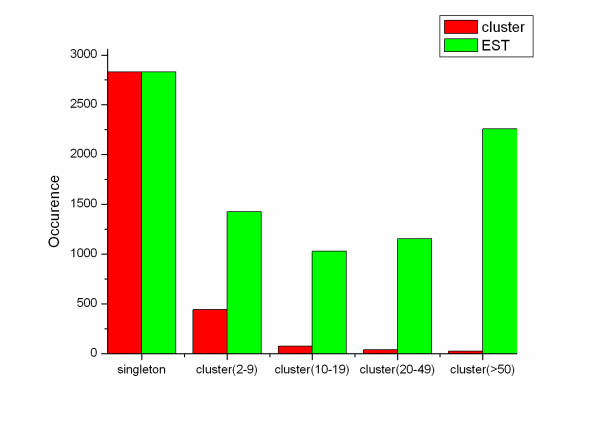
Prevalence distribution of the cluster size. The initial 8696 ESTs were grouped into 3416 clusters, consisting of 25 clusters (2257 of 8696 ESTs) that compromised of more than 50 ESTs each cluster, 39 clusters contained 20~49 ESTs (1153 of 8696 ESTs), 75 clusters contained 10~19 ESTs (1029 of 8696 ESTs), 445 clusters comprised 2~9 ESTseach cluster (1425 of 8696 ESTs), and 2832 unique sequence.